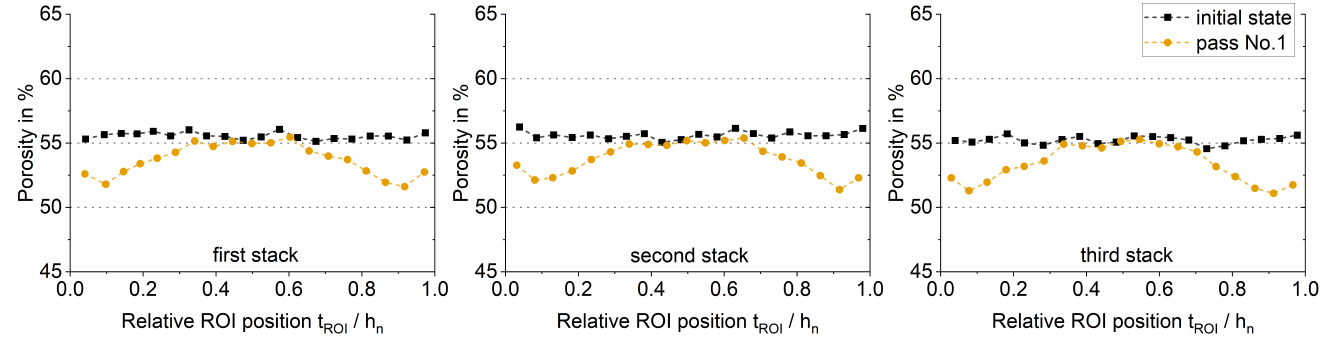
Figure A11. Series II: 20-0.05-1 ( l d / h m ≈ 0.5): Porosity change over relative sample depth (0=upper surface; 0.5= mid-section of sample; 1 =lower surface) due to rolling for first, second and third stack.